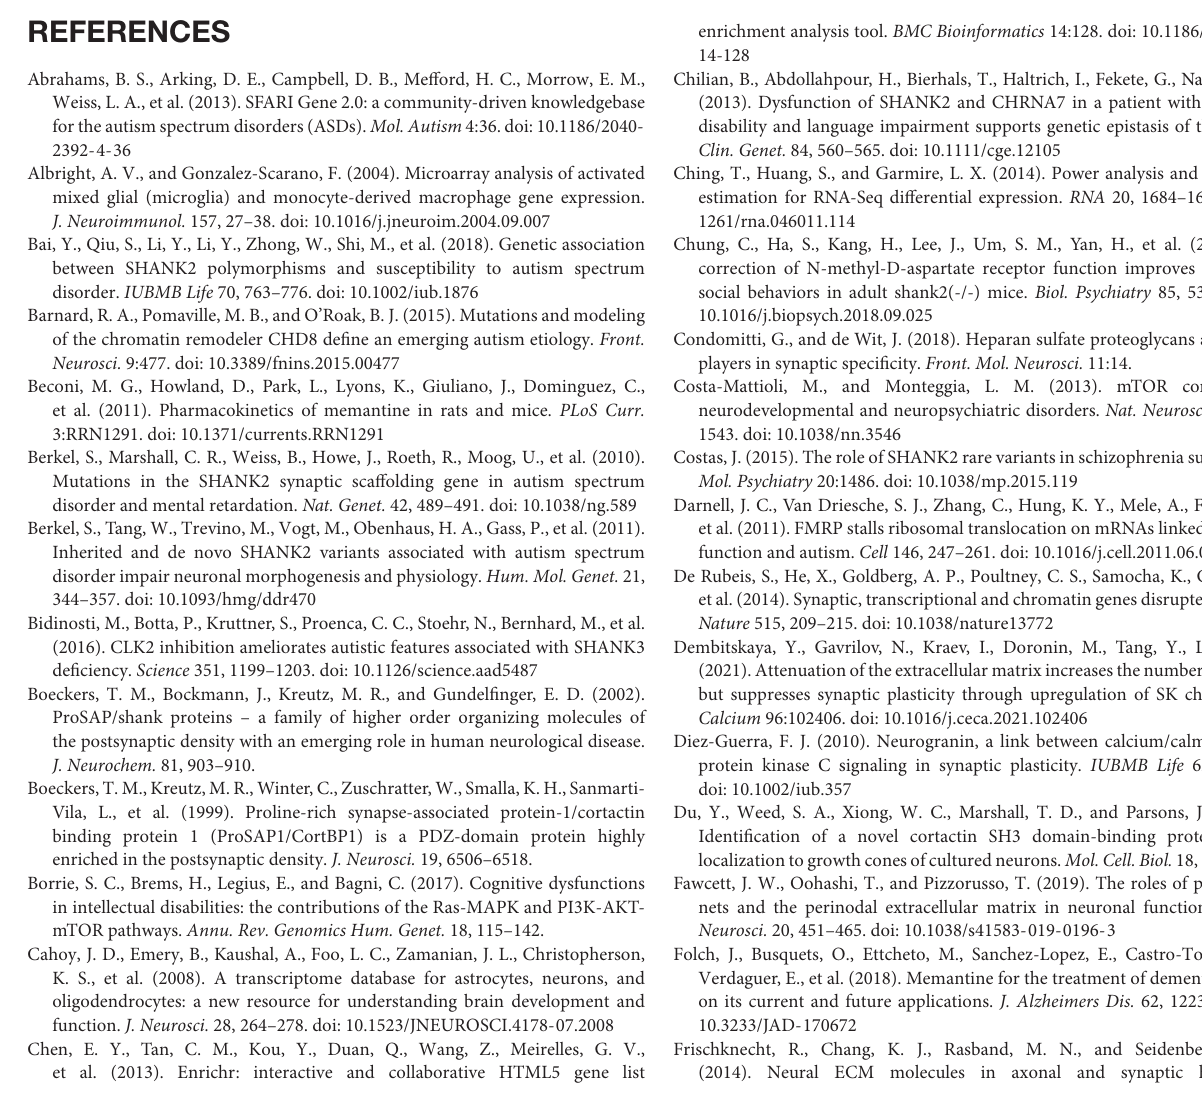
sets. Positive, insignificant, and negative enrichments for individual, or groups of, gene sets are indicated by red, black, and blue colors in texts/numbers. Enrichment results for single-cell-based cell-type-specific gene sets were summarized here for redundancy. Supplementary Figure 10 | Gene Set Enrichment Analysis results of four transcript groups (Veh-K/W, Mem-K/W, KO-M/V, and WT-M/V) for KEGG signaling pathway gene sets. GSEA results for all four transcript groups (Veh-K/W, Mem-K/W, KO-M/V, and WT-M/V) showing enrichment patterns for selected KEGG biological-pathway gene sets, including mTOR signaling. [ n = 3 mice (Veh-K/W, Mem-K/W, KO-M/V, WT-M/V), FDR < 0.05]. Supplementary Table 1 | Total RNA-Seq results of forebrain transcriptomes from early and chronically vehicle/memantine-treated WT and Shank2 -KO mice. Supplementary Table 2 | Lists of up- and downregulated DEGs in Veh-K/W, Mem-K/W, KO-M/V, and WT-M/V transcripts. Supplementary Table 3 | Results of Enrichr analysis for DEGs in Veh-K/W and Mem-K/W transcripts (CC, BP, MF, and KEGG). Note that Enrichr analysis for DEGs in WT-M/V and KO-M/V transcript did not yield significant functional annotations in GO terms. Adjusted p -values < 0.05.